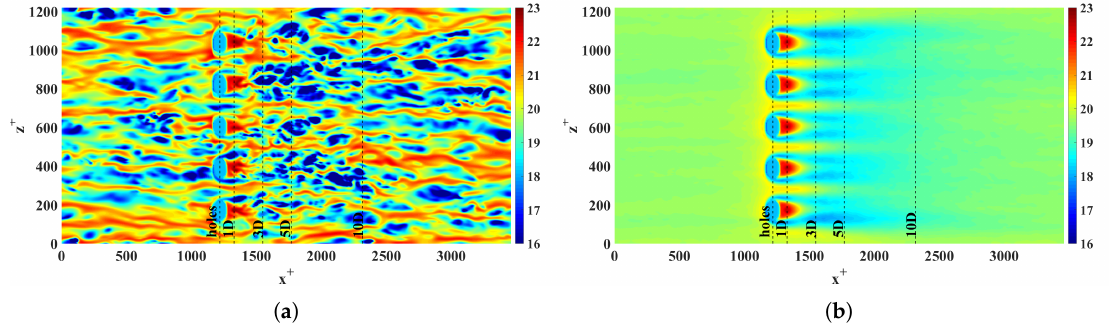
Figure 4. ( a ) Instantaneous and ( b ) mean temperature contours at y + = 5 on the xz plane. Both instantaneous and mean temperatures are normalized by Θ bw and Θ tw , as shown in Section